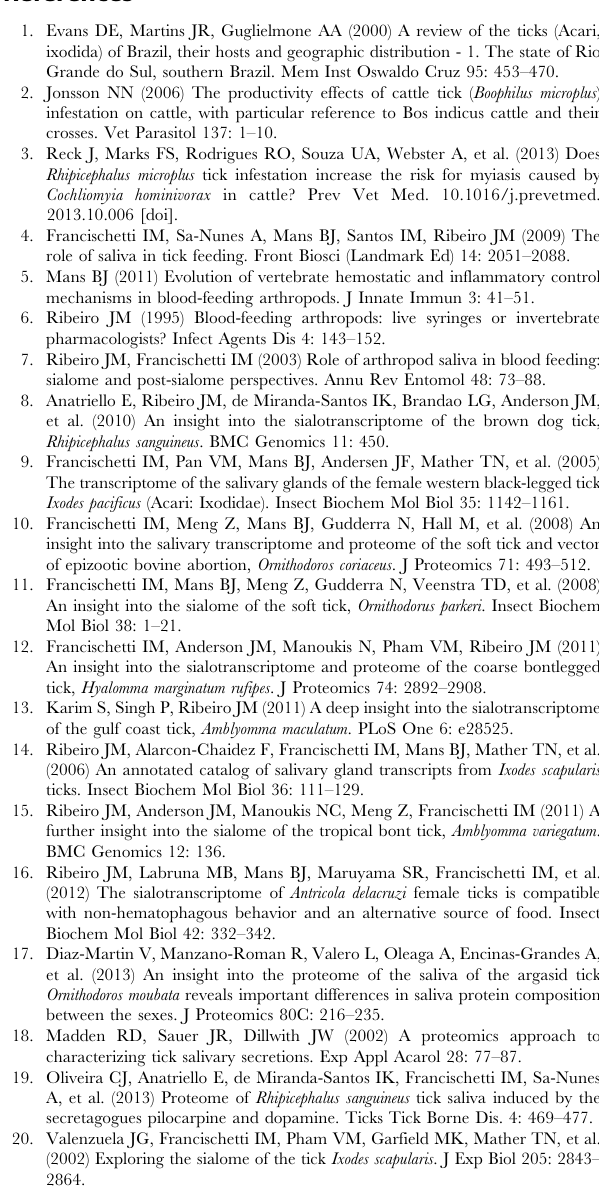
Table S1 Tick and host proteins identified in partially engorged female saliva by 1D-LC-MS/MS.